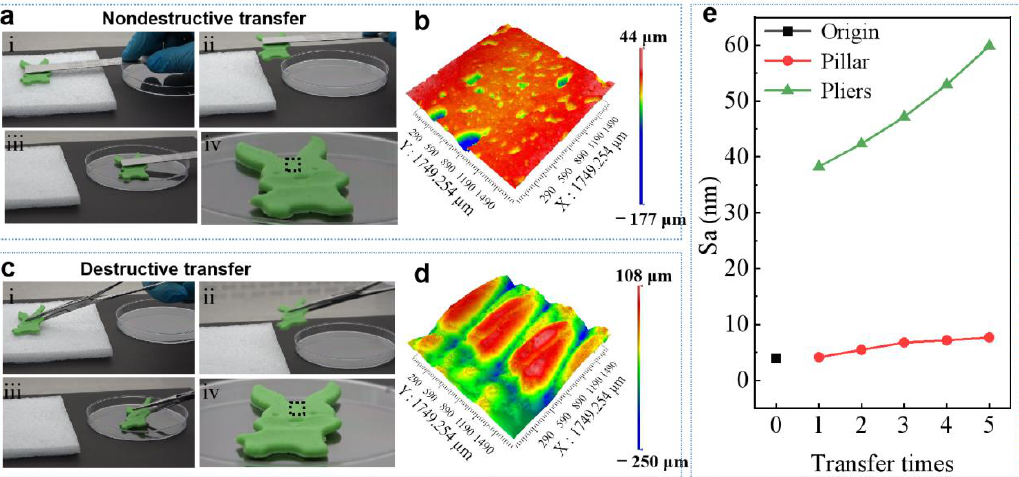
Figure 5. Application of GP adhesion. ( a ) Using a GP grasper to transfer a soft plasticine toy and ( b ) the 3D image, showing the surface of soft object intact as indicate by dashed box in ( a ). ( c ) Using a shape pliers grasper to transfer a soft plasticine toy and ( d ) the 3D image, showing the surface of soft object damaged as indicate by dashed box in ( c ). ( e ) The Sa of the soft plasticine toy after five transfers.